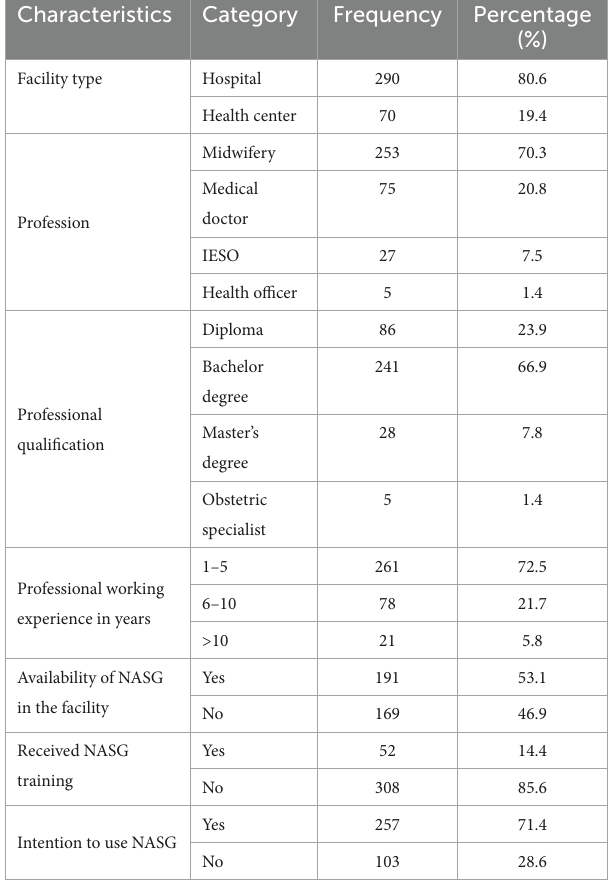
TABLE 2 Working place and profession-related characteristics among healthcare providers in north Shew Shewa zone health facilities, 2021 ( n =